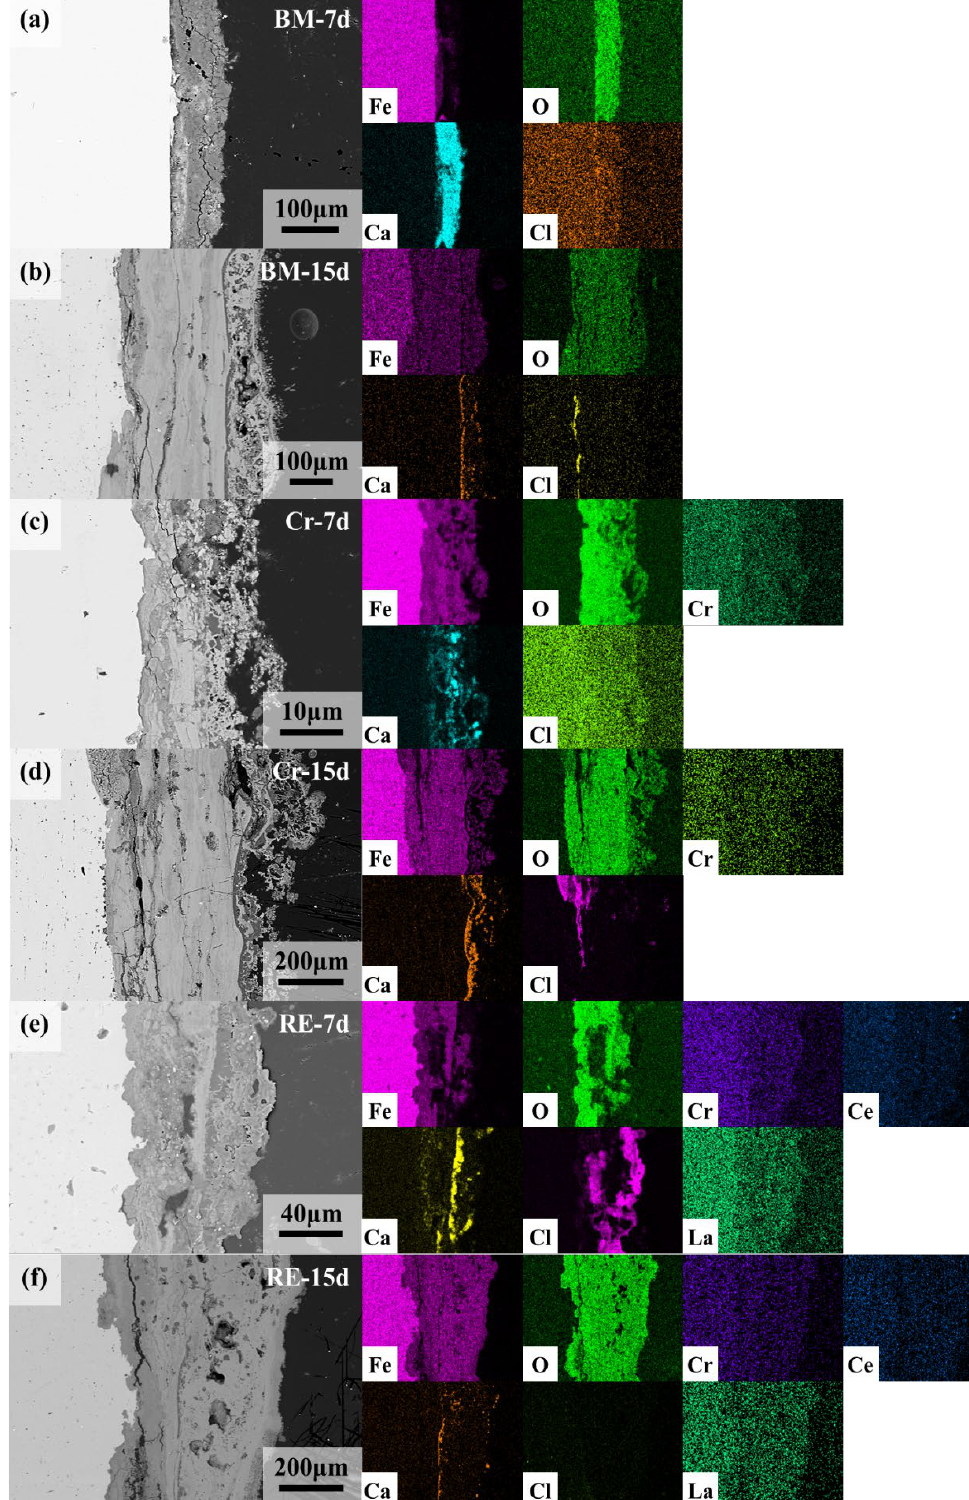
Figure 12. Cross-section morphologies and element distribution mappings of the corrosion product film (CPF) of the three steel rebars after the corrosion process in the marine-reinforced concrete pore fluid simulation environment: ( a ) BM-7d, ( b ) BM-15d, ( c ) Cr-7d, ( d ) Cr-15d, ( e ) Re-7d, and ( f ) RE-15d.